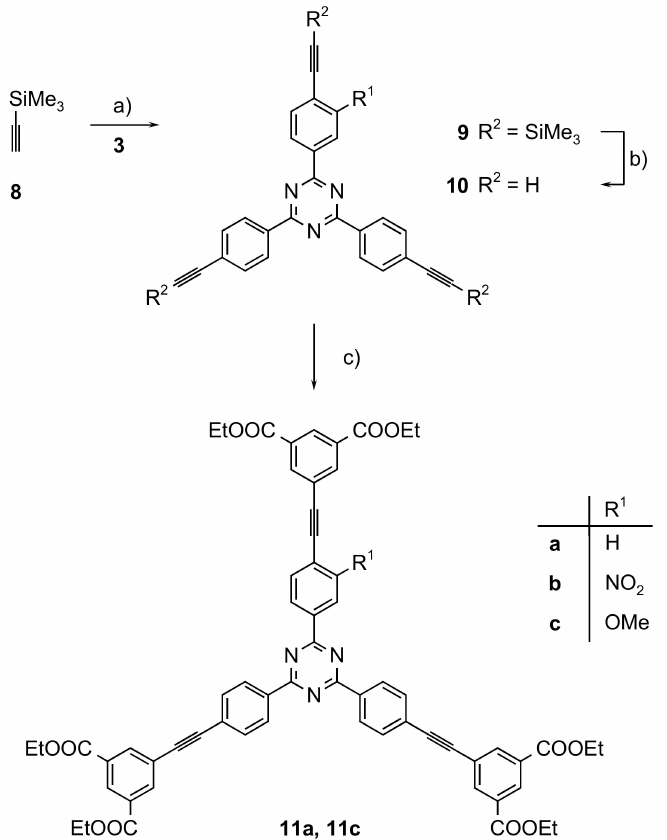
Figure 4. Syntheses of hexadentate mono-substituted alkyne containing triazine based linkers 11 :